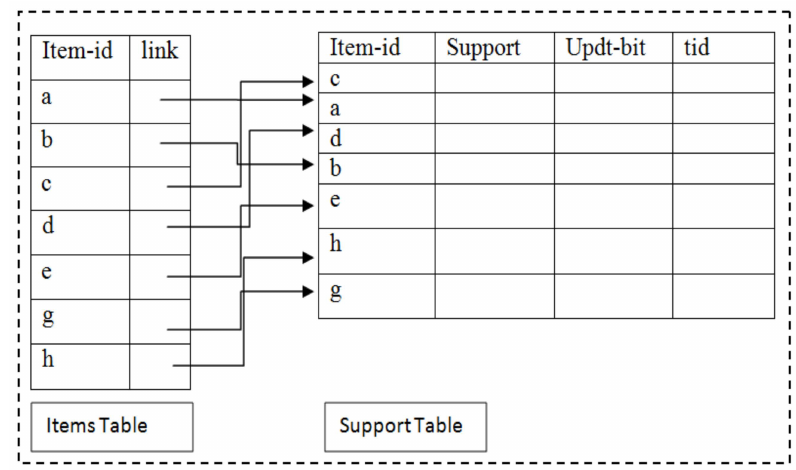
Figure 2. Structure of ISI-tables.